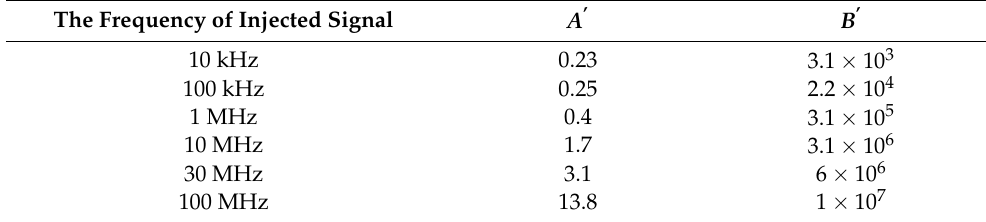
Table 3. The parameters of A (cid:48) and B (cid:48)